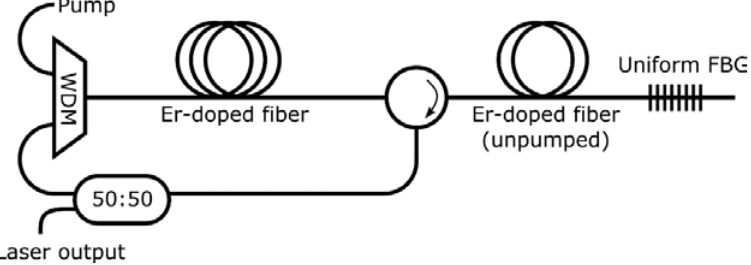
Figure 3. Erbium doped fiber sigma-cavity laser (EDSCL) sensor configuration. Two types of